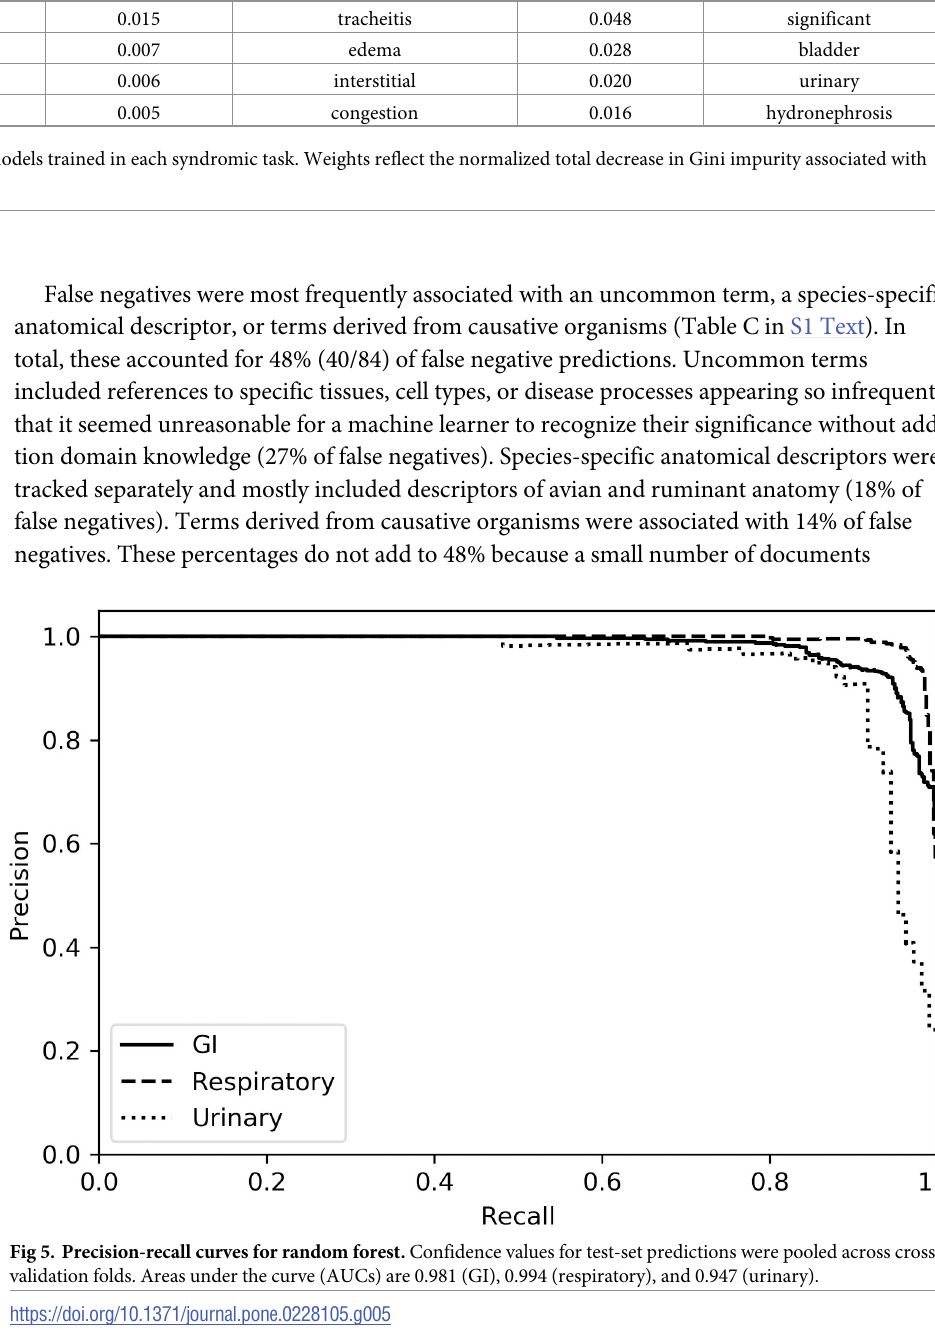
The most important features for random forest models trained in each syndromic task. Weights reflect the normalized total decrease in Gini impurity associated with each